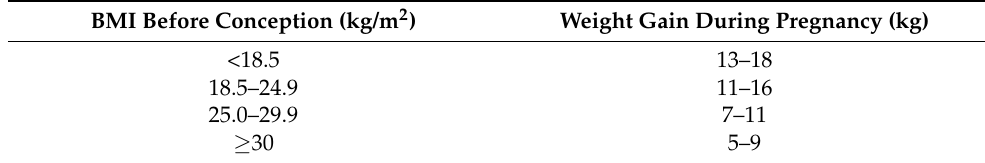
Table 2. Recommended weight gain during